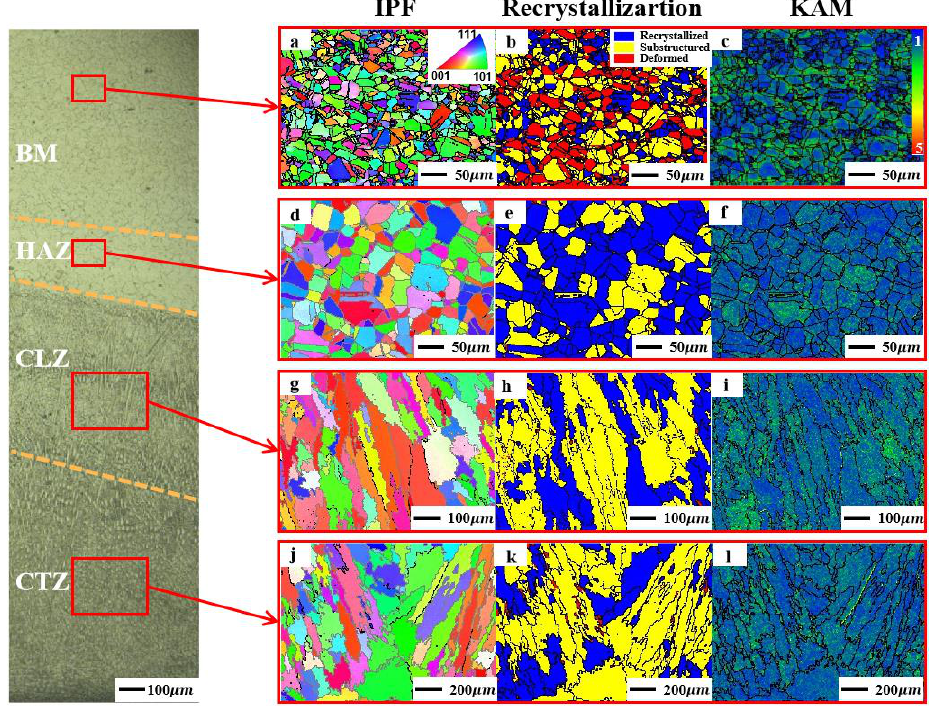
Figure 3. The IPF, recrystallization diagram, and kernel average misorientation (KAM) diagram of different areas of the sample after 700 mA electron beam scanning: ( a,b,c ) BM, ( d,e,f ) HAZ, ( g,h,i ) CLZ, ( j,k,l ) CTZ.